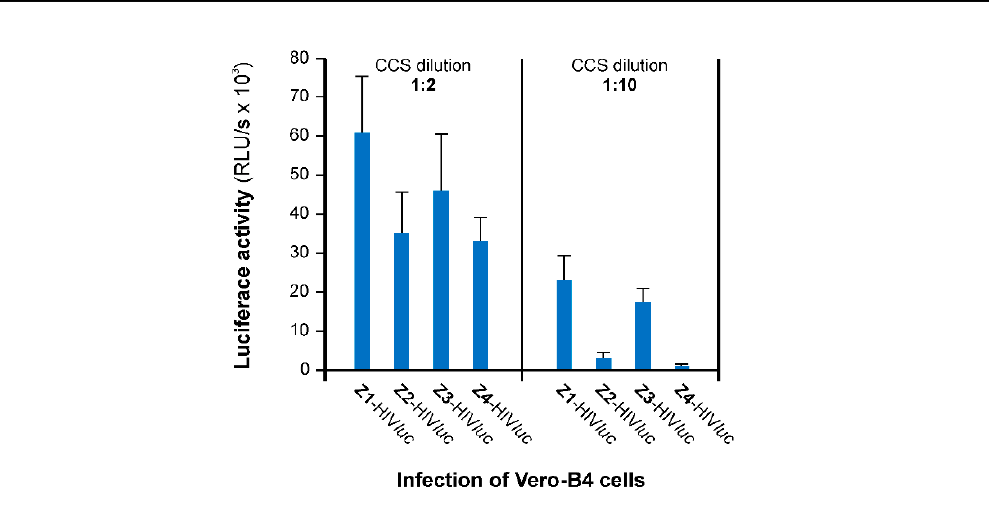
Figure 2. Efficiency of Vero-B4 infection by Zika pr ME pseudotypes. CCSs containing the Z1 to Z4-HIV luc pseudotype particles were tested at 1:2 and 1:10 dilution. Luciferase activity was